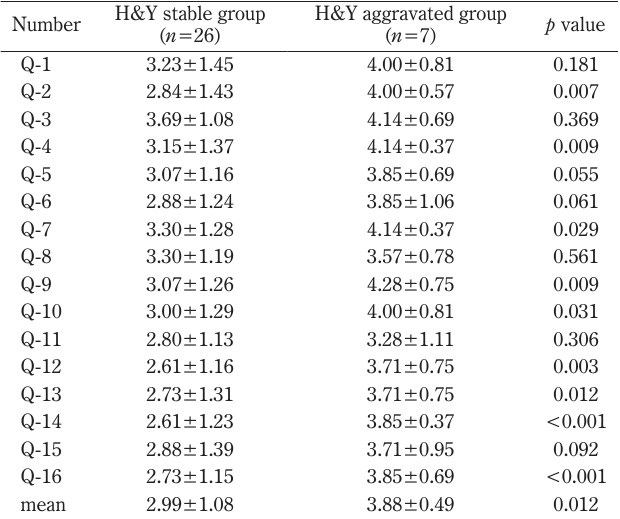
Table 4 Comparison for the 16-item Parkinson Fatigue Scale between H&Y stable and aggravated groups